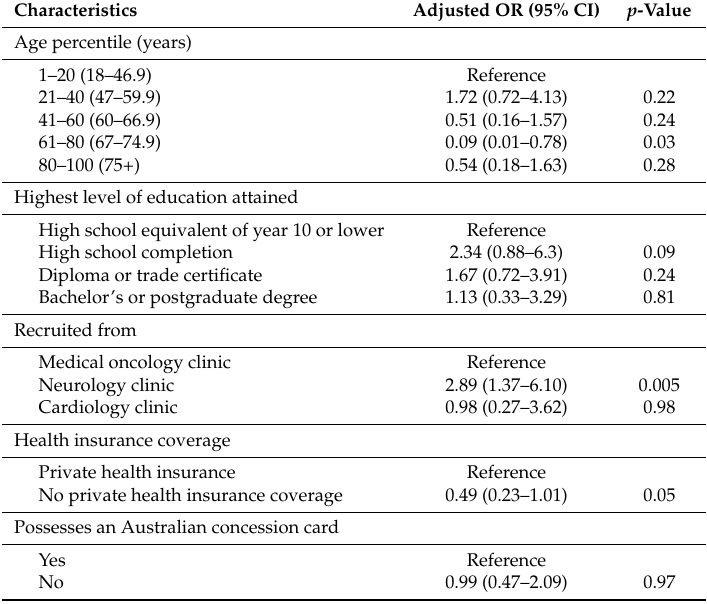
Table 5. Adjusted odds of selecting “Assistance or information to manage emotional symptoms”.